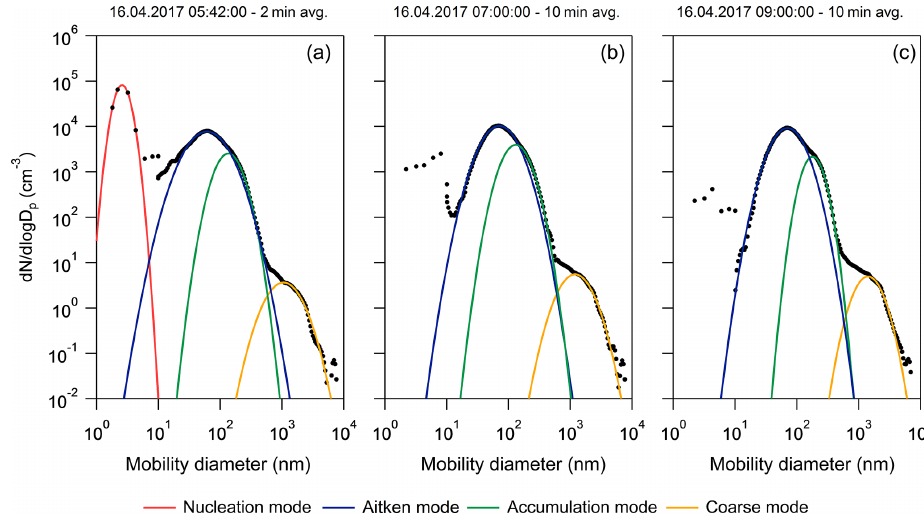
Figure 4. Averaged full number size distribution DMA-train data resolving particle diameters < 10nm, MPSS data ( > 10nm) and APS data ( > 800nm). Nucleation mode, Aitken mode, accumulation mode and coarse mode were fitted using a log-normal function. Panel (a) shows the size distribution during the NPF event on 16 April 2017, with a clear nucleation mode appearing which is reduced at 07:00UTC, as shown in panel (b) . In panel (c) , the size distribution after the NPF is demonstrated. Uncertainties in the number concentration are estimated as 20% for diameters < 10nm, 30% between 10 and 20nm, and 10% for diameters beyond 20nm.